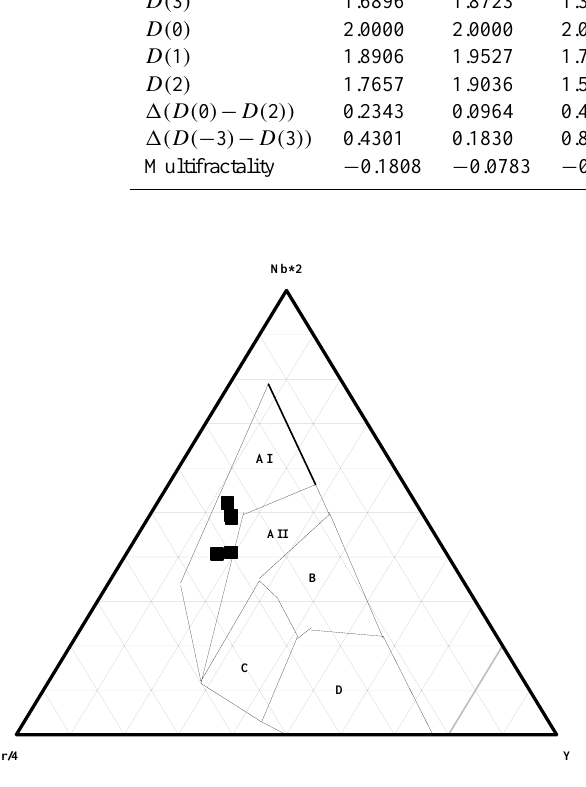
Fig. 4. Discrimination Nb-Zr-Y diagram (Meschede, 1986) for Fig. 4 . Discrimination Nb-Zr-Y diagram (Meschede, 1986) for basalts from the four segments. basalts from the four segments. (AI, AII = fields of intraplate alkali (AI, AII = fields of intraplate alkali basalts; AII, C = fields of intraplate tholeiites; B = field of P- basalts; AII, C = fields of intraplate tholeiites; B = field of P-type field of N-type MORB; C, D = fields of volcanic arc basalts.) MORB; D = field of N-type MORB; C, D = fields of volcanic arc basalts.) 0.11.010.0100.01000.010000.0